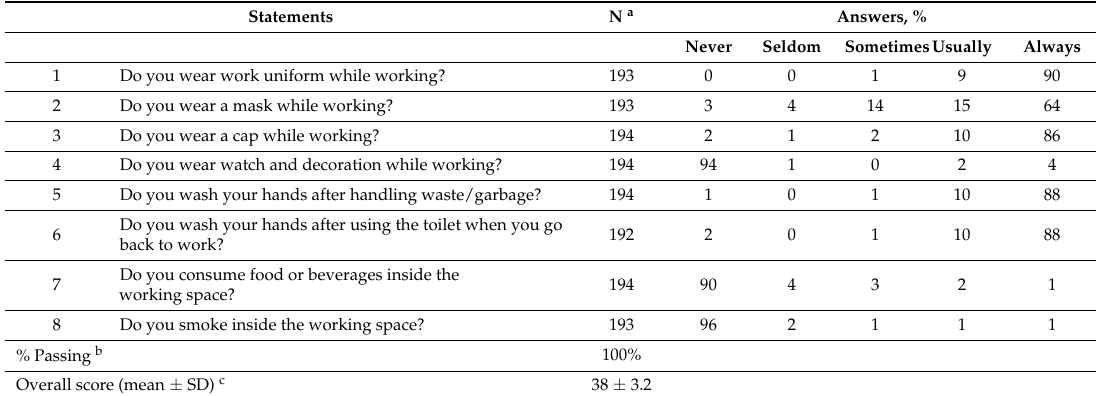
Table 4. Food safety related behavior among dairy plant